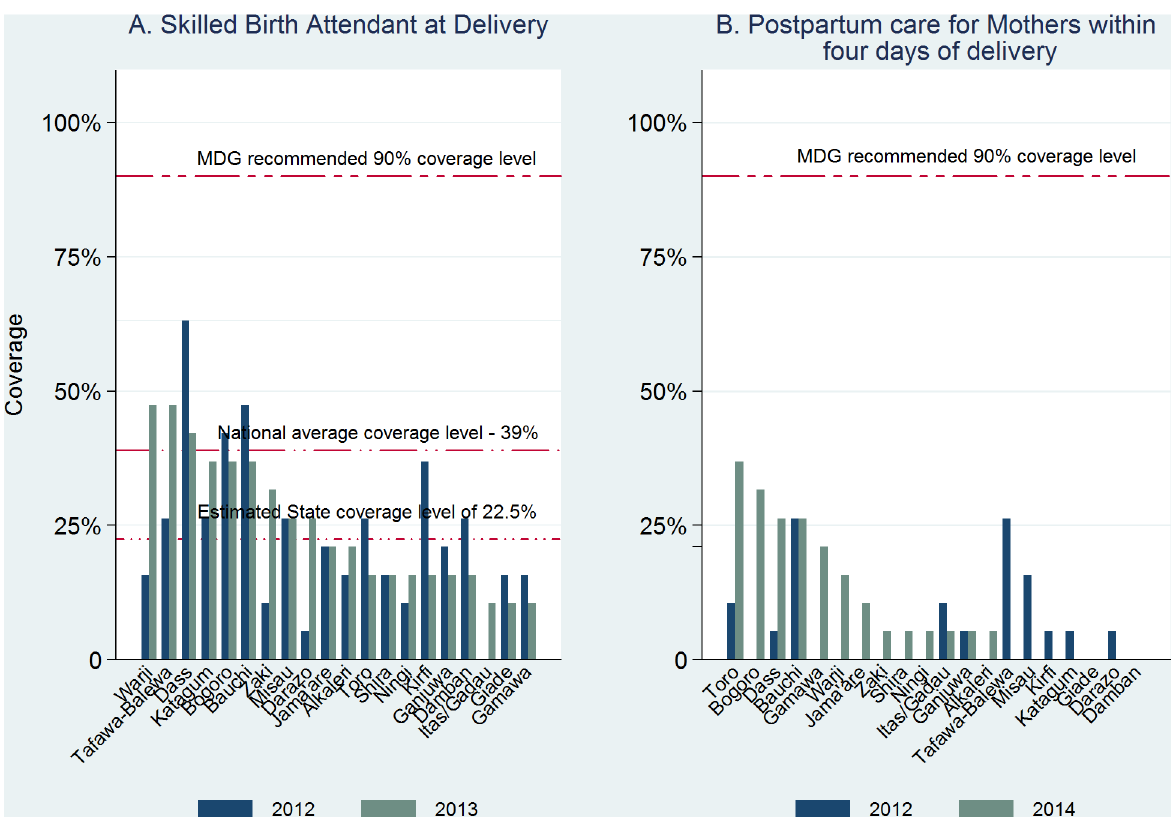
Fig 3. Birth and postpartum continuum: coverage of Skilled birth attendant at delivery and postpartum care at least four days after delivery. 2012 and 2014 by LGA.